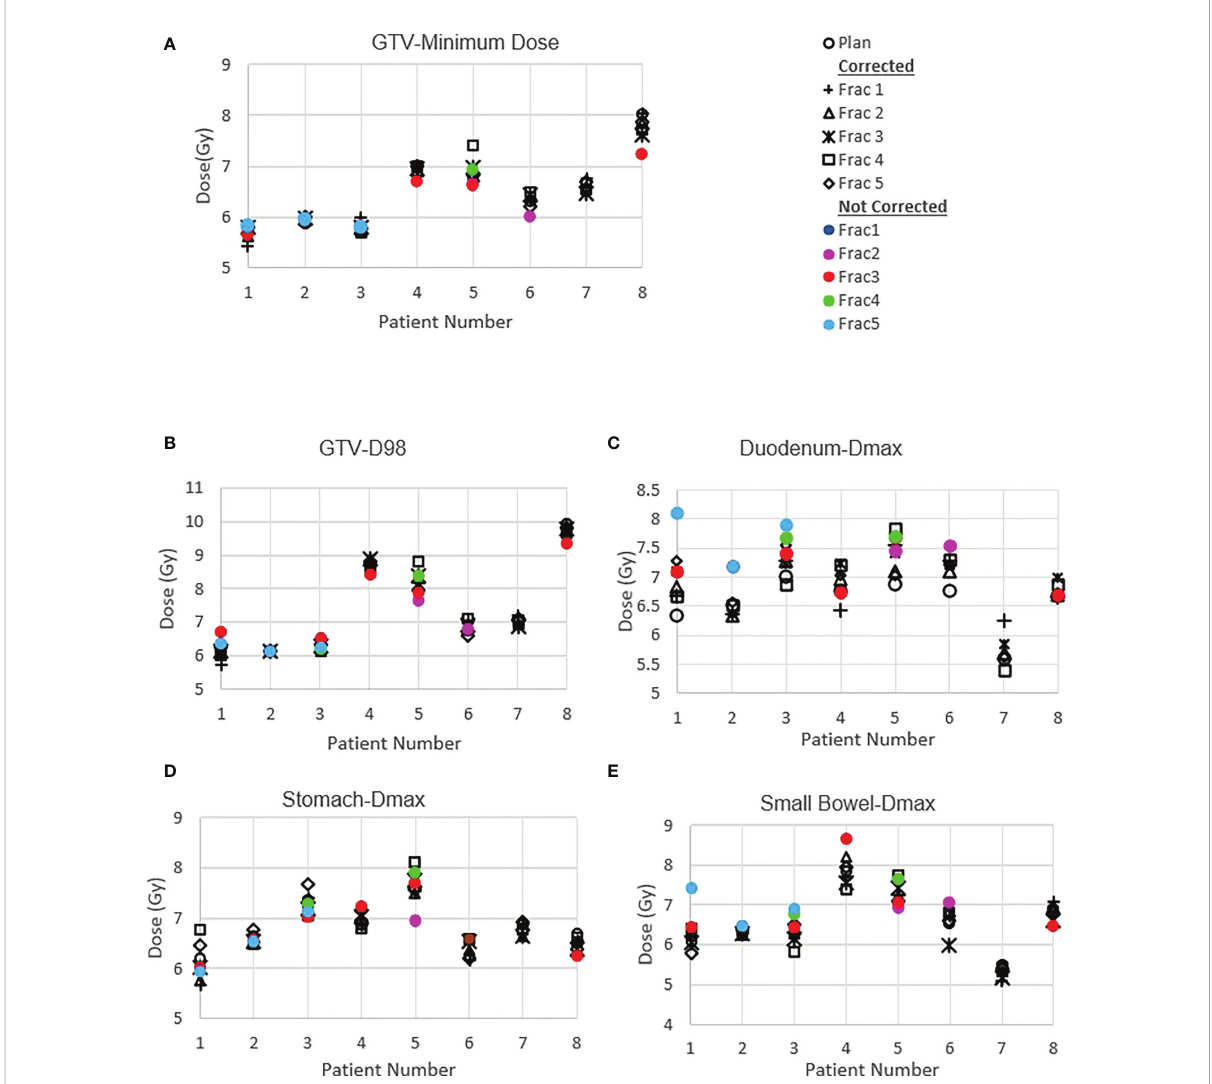
FIGURE 4 Planned and delivered DVH metrics, corrected for position deviations, of GTV (A, B) and gastrointestinal OARs Duodenum (C) , Stomach (D) and Small Bowel (E) for individual treatment fractions. The delivered DVH metrics are derived from the CP dose matrices convolved with the real- time target position determined during treatment delivery. The dose that would have been delivered with position deviations not corrected in the absence of real-time position monitoring also shown in the same fi